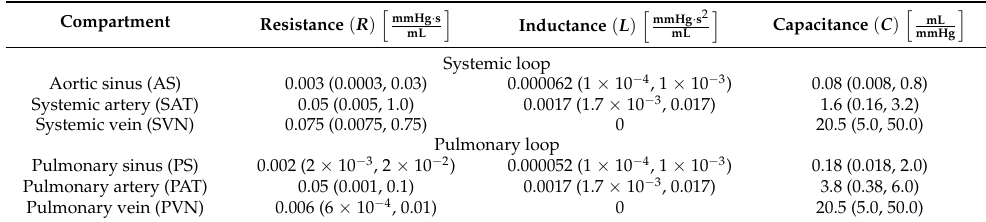
Table 2. Systemic and pulmonary loop parameters (values in parentheses are used for the upper and lower boundaries)